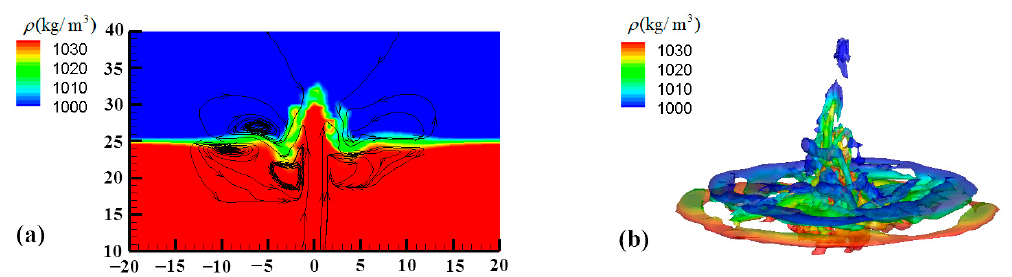
Figure 16. Instantaneous coherent structures of Case A6 at T = 0.58. ( a ) Streamline around the jet at the plane of Y = 0. ( b ) Isosurface of Ω = 0.55.